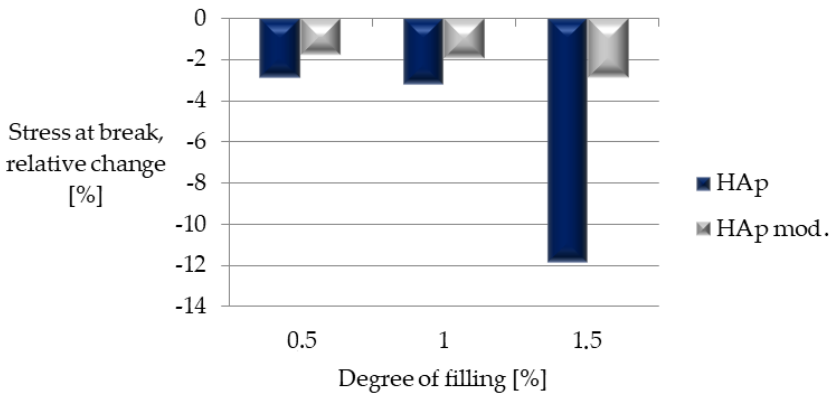
Figure 21. Relative change in breaking stress with respect to unfilled PLA.